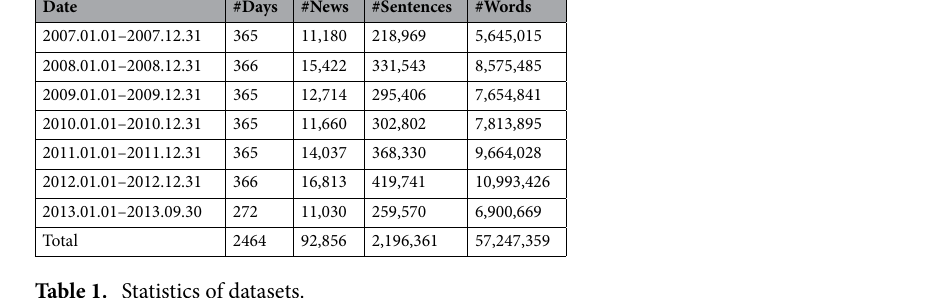
Table 1. Statistics of